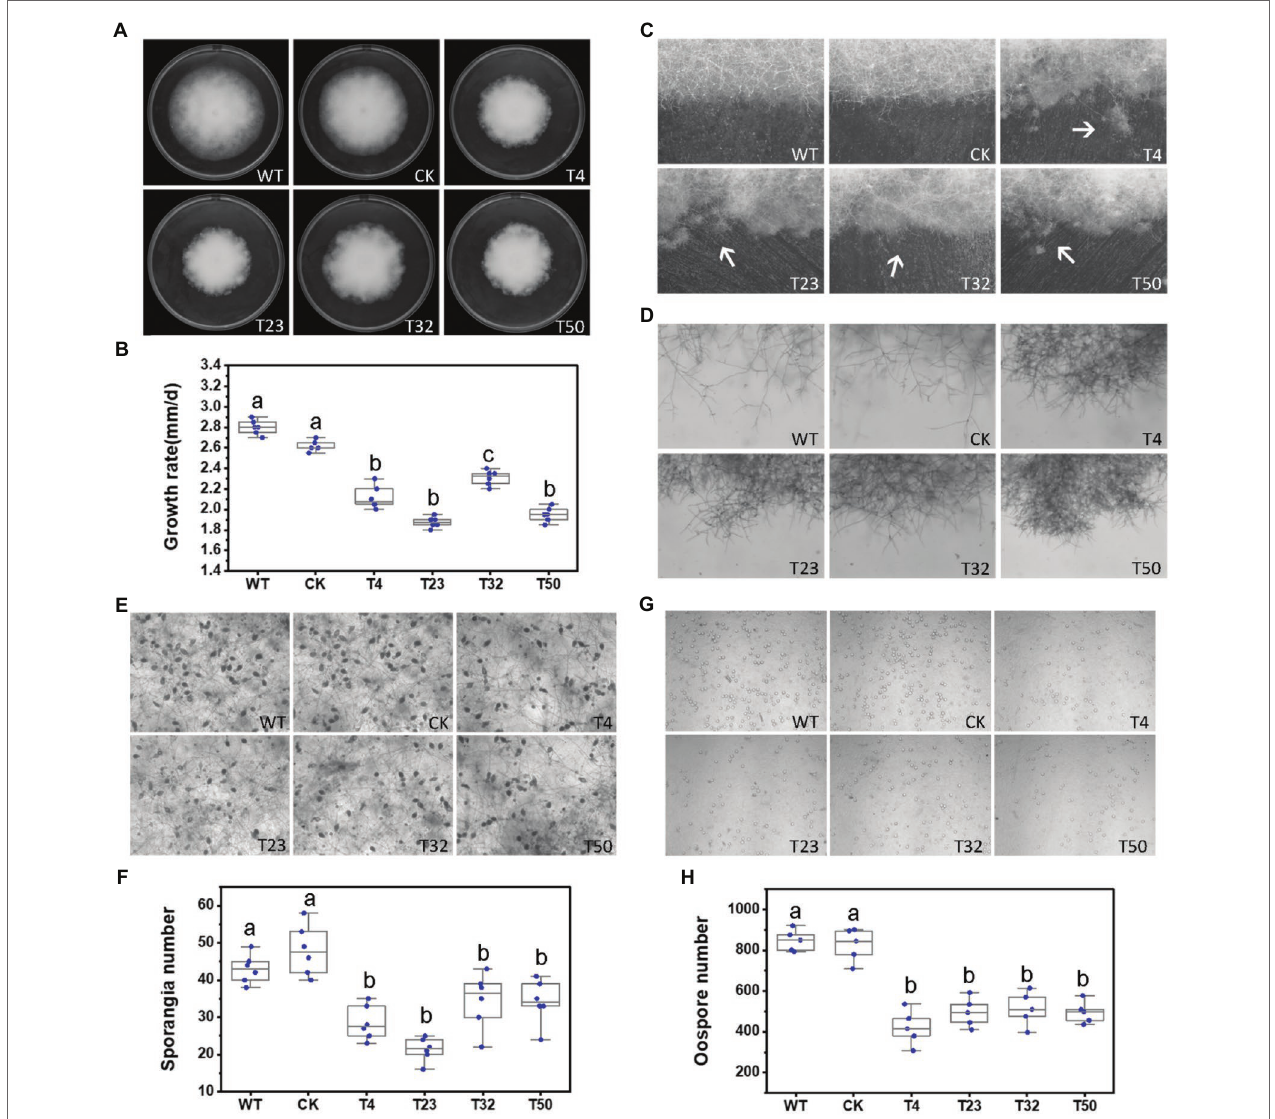
FIGURE 5 | Phenotypic analysis of PsBTS1 deletion mutants. Comparison of wild-type (WT) P. sojae with a control transformant (CK) and four PsBTS1 deletion mutants (T4, T23, T32, and T50). (A) Colony morphology and (B) growth rate on Plich medium. (C) Colony edges. (D) Mycelial morphology of satellite colonies. (E) Microscopic visualization and (F) quantification of sporangia. (G) Microscopic visualization and (H) quantification of oospores. In (F) and (H) a, b, and c indicate significant differences ( p < 0.05). Bar: 100 μ